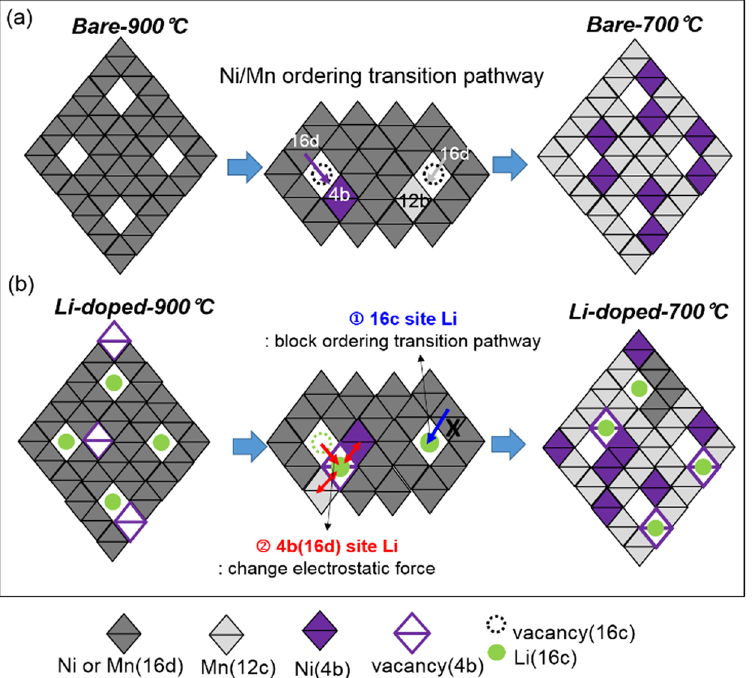
Figure 7. Schematic diagram of the Ni/Mn ordering transition pathway ( a ) bare sample ( b ) Li-doped sample (left: 900 °C structure, right: 700 °C